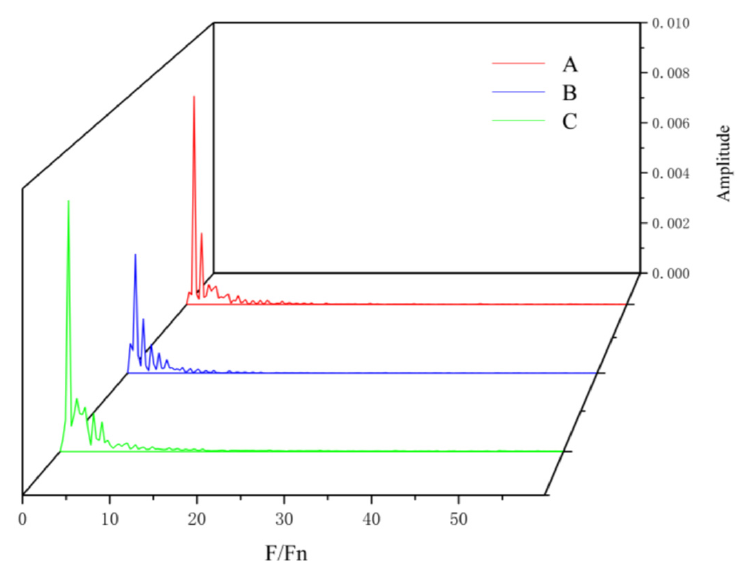
Figure 17. Pressure frequency of P8 in the rotor.